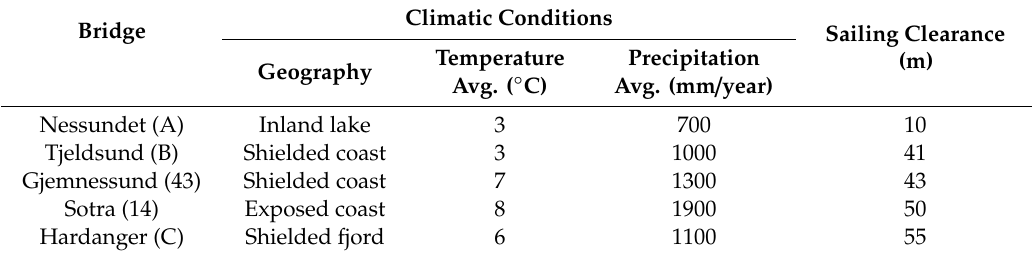
Table 1. The description of the bridges where corrosivity was measured. The location of the bridges is